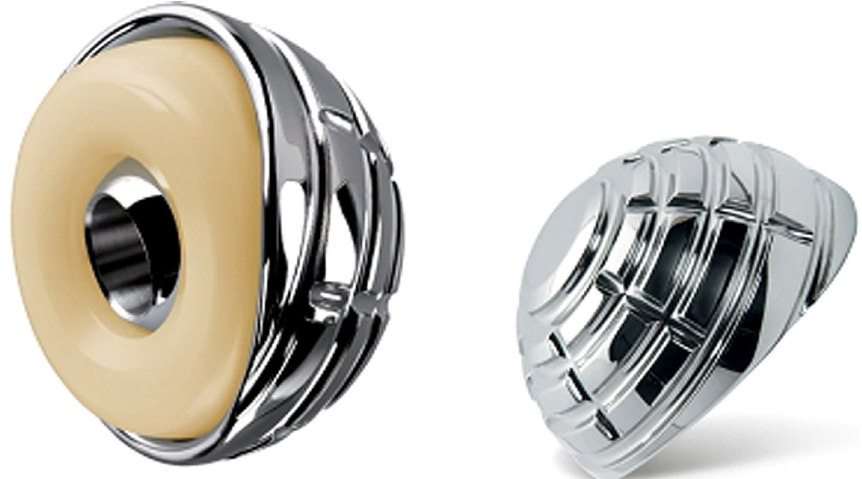
Figure 2. The cemented AVANTAGE (cid:2) Cup. The 3 mm thick cup cylindro-spherical design is characterized by a superior ‘‘cap’’. The figure is the property of Biomet, which have granted their permission for usage in this article.